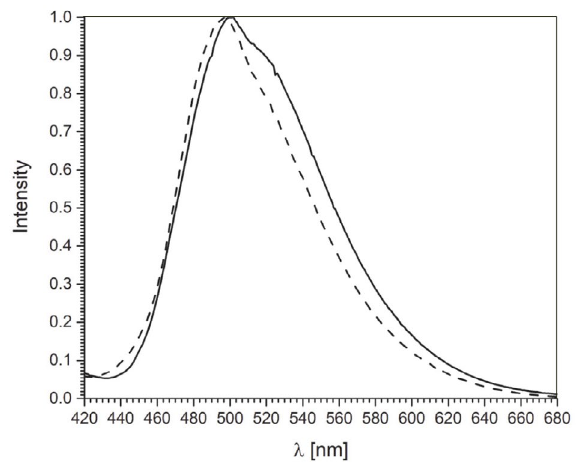
Figure 5. Normalized corrected emission spectra of 2 (solid) and 3 (dashed) complexes in solid